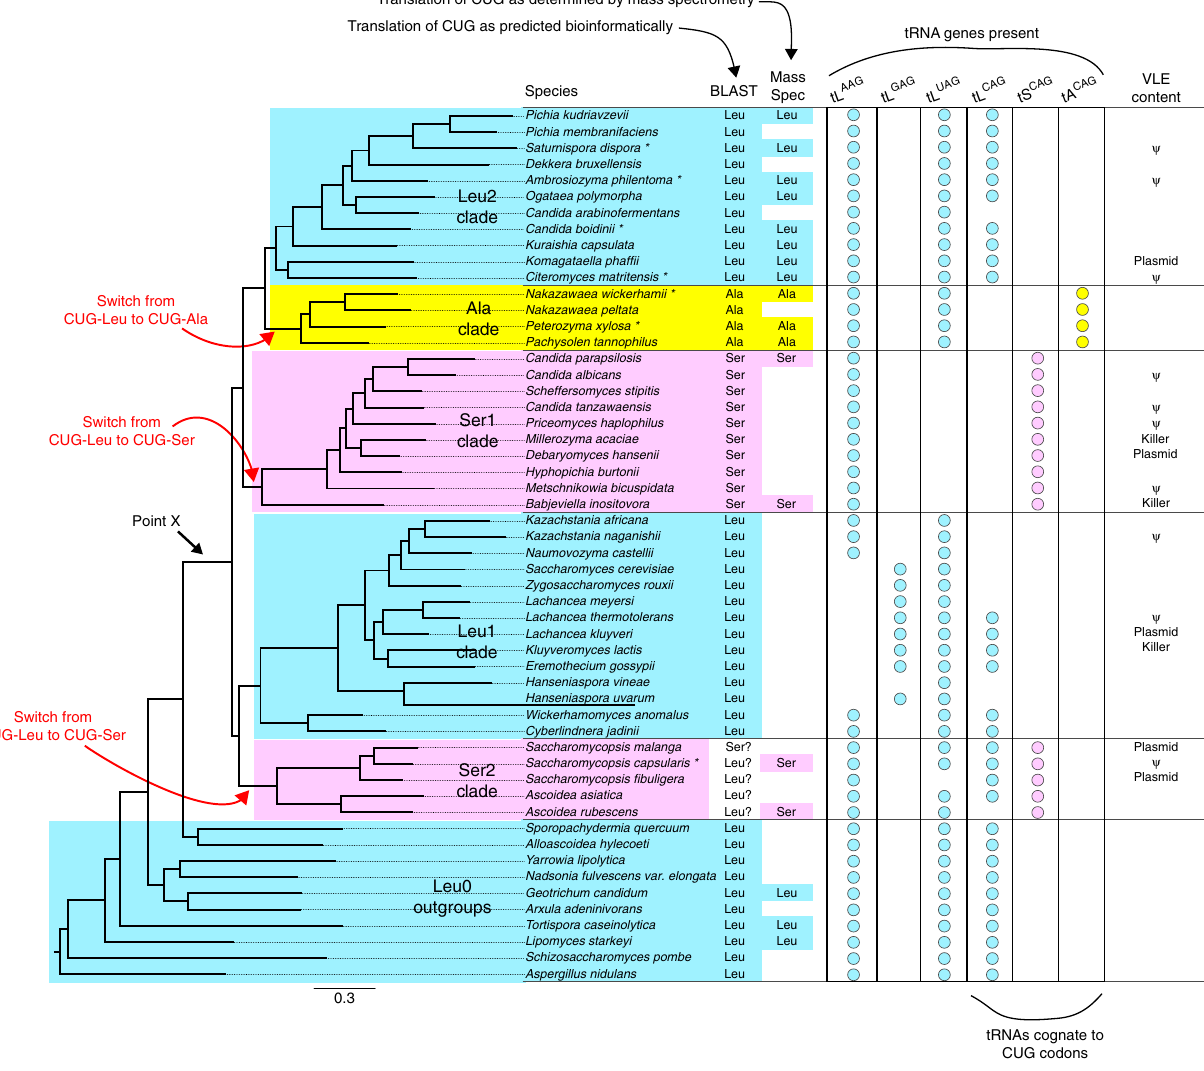
Fig. 3. The mass error values of CUG-translated residues were similar to those of other residues (Supplementary Fig. 4).